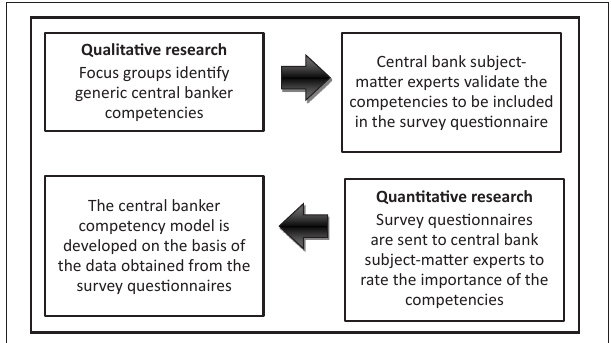
FIGURE 1: Evaluation criteria for assessing a competency model as constructed by the researchers.